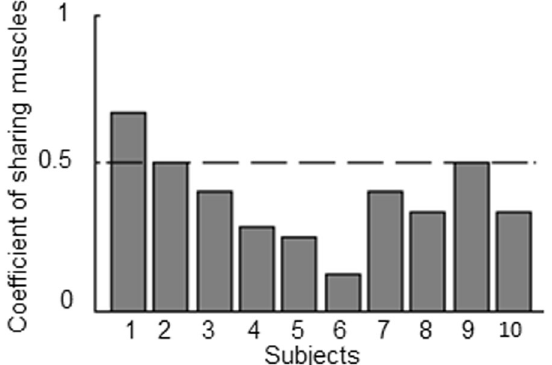
Figure 7. Coefficient of Shared muscles. Coefficient of shared muscles denotes the proportion of the muscles with activation strength higher than 0.5 in MSM and that are also in the MCM best model. Lower coefficient values indicate that MSM accounts for perceptual variance by means of different muscles than those belonging to the